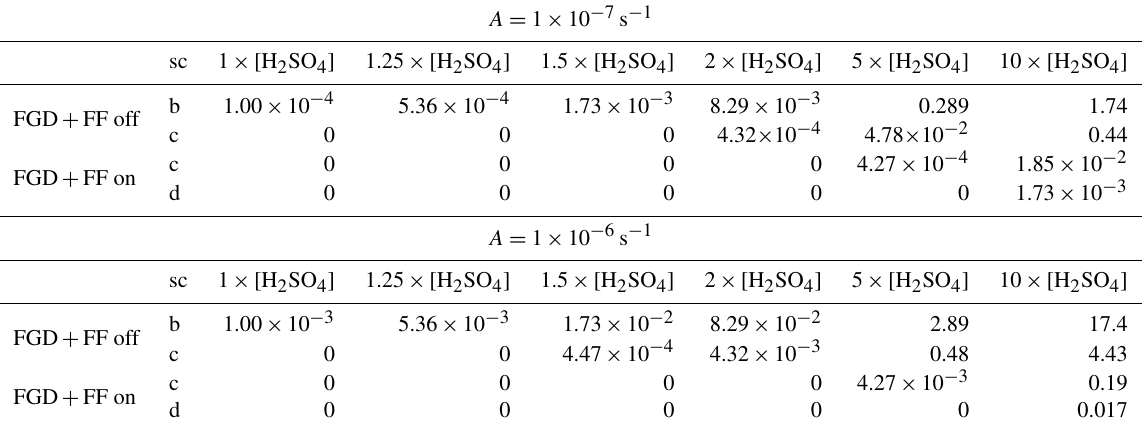
Table 3. Sensitivity analysis made for number of particles formed with diameters above 2.5nm during the flight (1cm − 3 s − 1 ) in the atmo- sphere with different values of A and [H 2 SO 4 ]. The [H 2 SO 4 ] is calculated based on the measurement results and scaled up to test faster nucleation rates for both FGD + FF on and FGD + FF off cases and stability classes